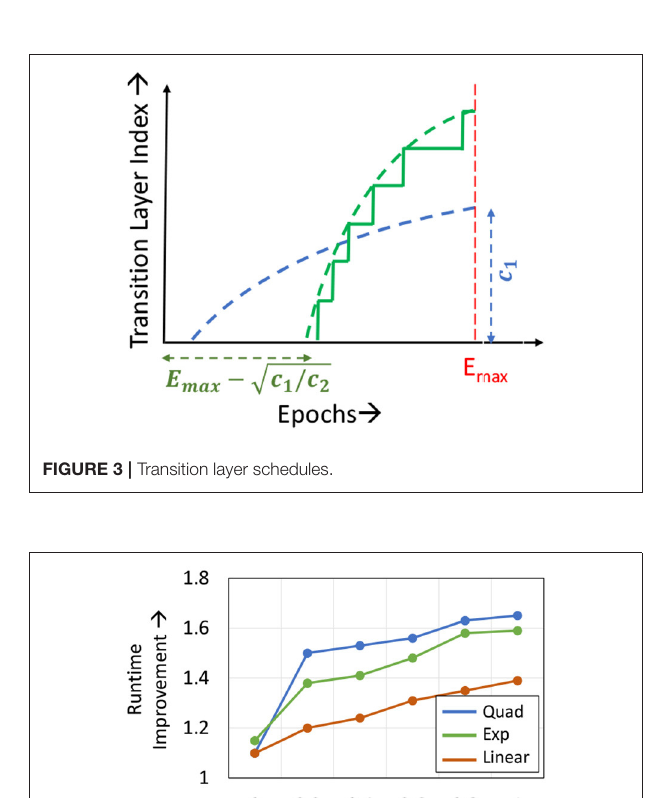
under the curve, i.e., employing localized updates as many layers and epochs as possible, while maintaining a competitive classification accuracy.